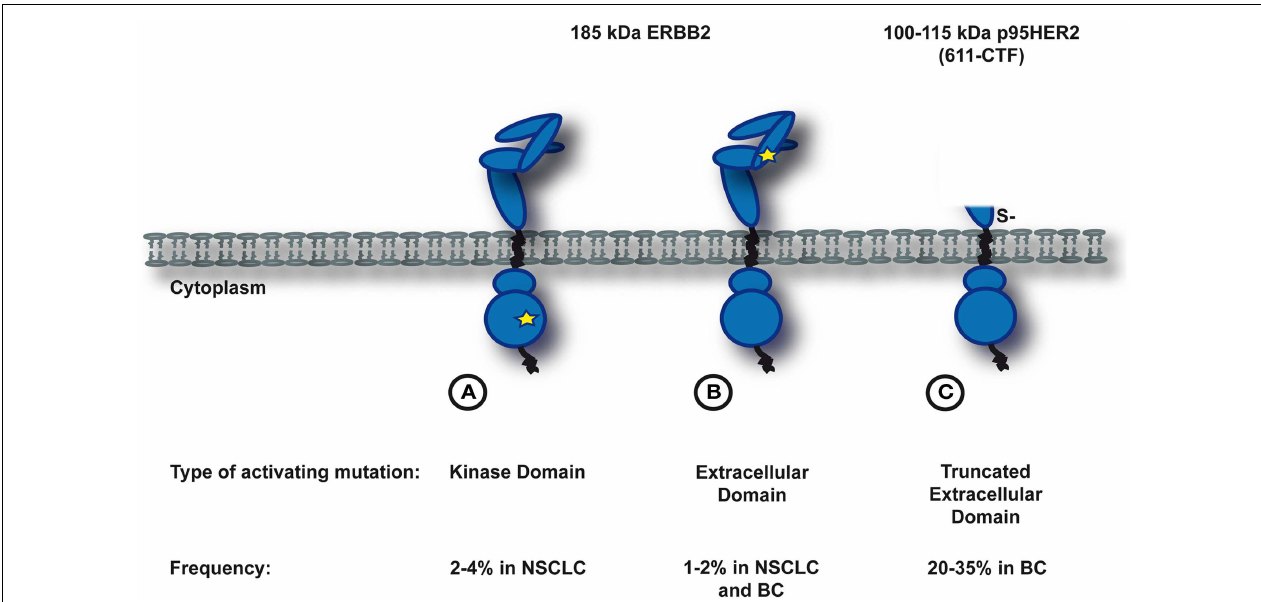
of the activating mutation ( A in the kinase domain, B in the extracellular domain). (C) Large deletions of the extracellular domain that yield the trucated form of ERBB2,